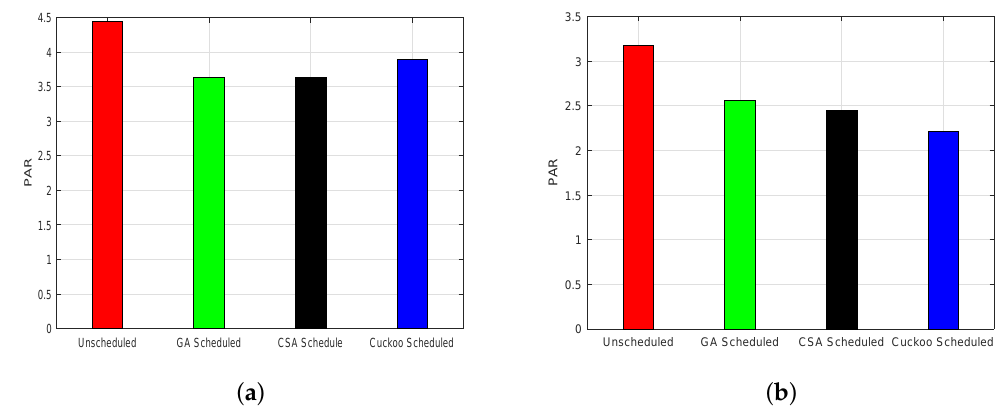
Figure 13. PAR for single and multiple homes with RTP signals. ( a ) PAR for a single smart home; ( b ) PAR for 30 smart homes.